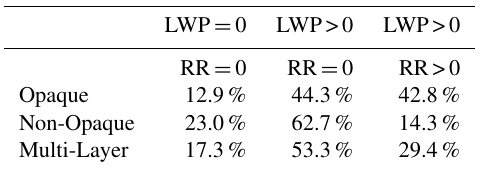
Table 4. The relative occurrence frequencies of non-zero liquid wa- ter path and rain rate according to coincident AMSR pixels for the three ice cloud categories defined in Table 3. These results are ob- tained over the Tropical oceans ( ± 18 ◦ ) during July and August from